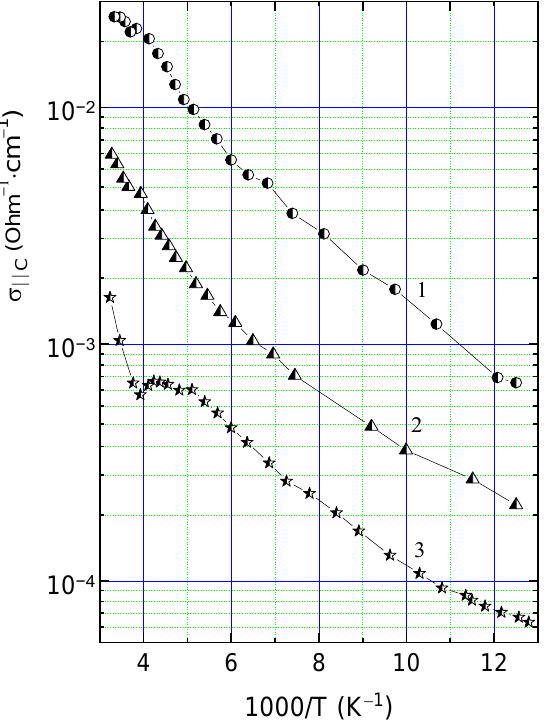
Figure 7. The out-of-plane electrical conductivity (i.e., across the van der Waals layers) versus temperature for as-grown pristine (1), Co-intercalated (2), and Co-doped (3) crystals of n -type InSe.